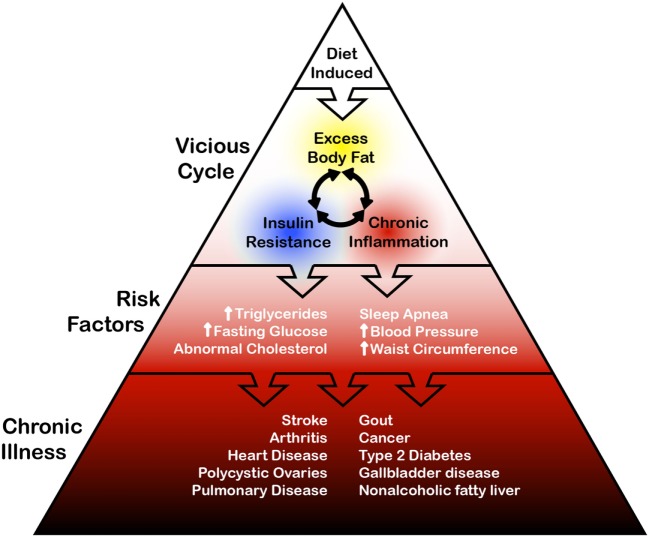
General schematic of relationships between diet, overfat, some risk factors, and chronic illness.